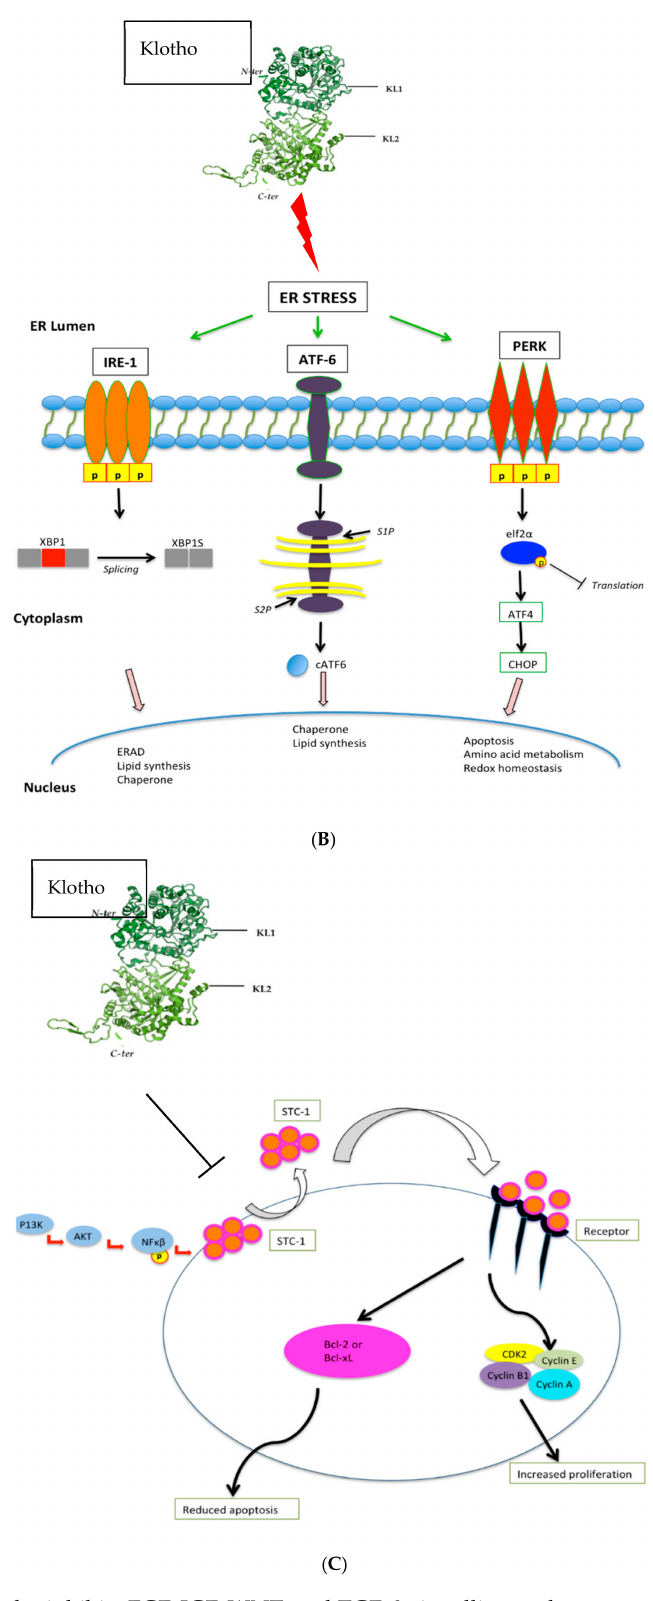
Figure 2. ( A ). Klotho inhibits FGF, IGF, WNT, and TGF- β signalling pathways, resulting in reduced tumour growth, tumour migration, tumour invasion, cell proliferation, and protein synthesis. ( B ) Klotho activatestheUnfoldedProteinResponse, causingactivationofPERK-elfF2 α pathwayandthesubsequent increase in pro-apoptotic signals. ( C ). Klotho inhibits the Stanniocalcin pathway, resulting in decreased cell proliferation and increased cell